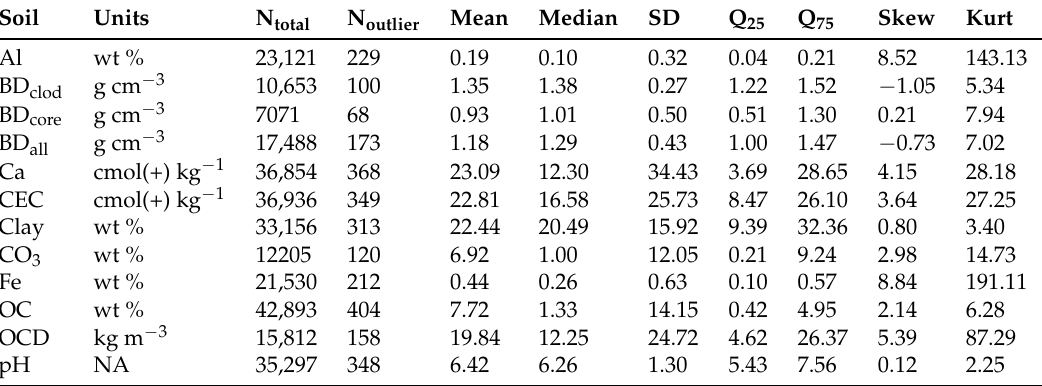
Table 1. Summary statistics of soil properties available through the NSSC KSSL MIR